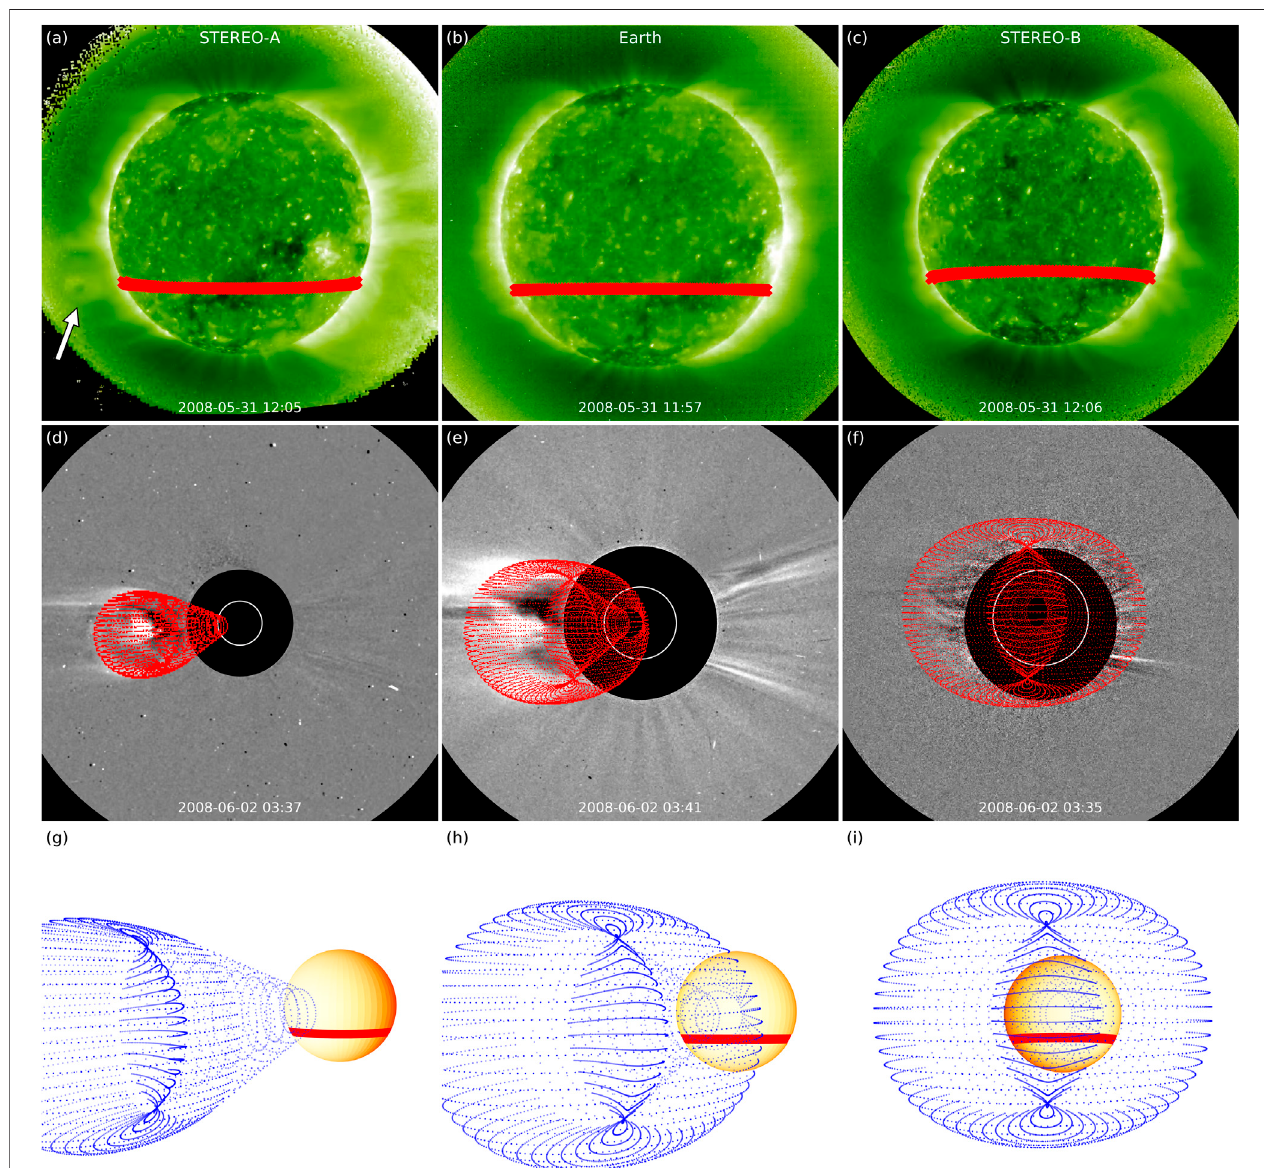
FIGURE2| Geometrictechniquesappliedtothe2008June1CME(Event1). (A – C) Latitude(thickredline)oftheCMEcore(indicatedwithanarrow)projectedonto thesolardiscasseenbySTEREO-A,SOHO,andSTEREO-B. (D – F) GCSreconstructionappliedtothewhite-lightstructureseeninSTEREO-A,SOHO,andSTEREO-B imagery. (G – I) The GCS-reconstructed CME displayed together with the “ source latitude ” in a 3D representation and shown from the three viewpoints of STEREO-A, Earth, and STEREO-B.